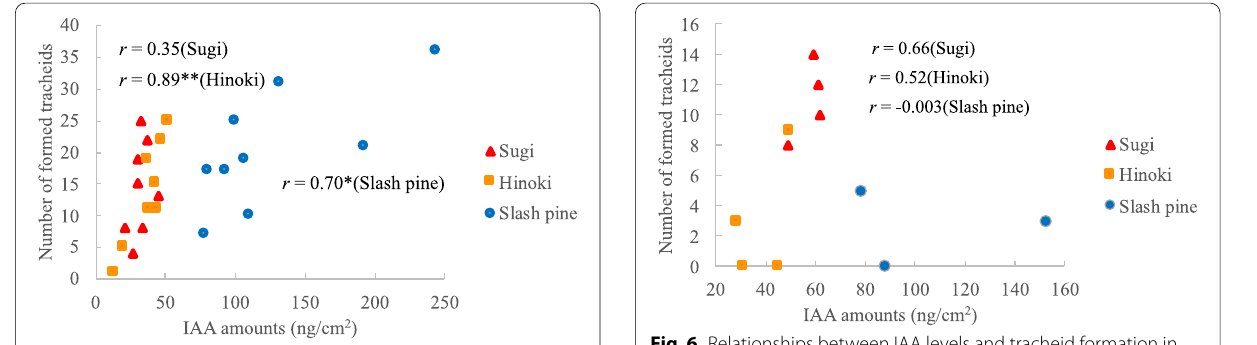
Fig. 5 Relationships between IAA levels and tracheid formation in three conifers during late season. Sugi and hinoki data were from July and September, and slash pine data were from July, September, and November. For example, the plotted data for July include the IAA levels in July and the number of tracheids formed in test period II. **p < 0.01, *p < 0.05